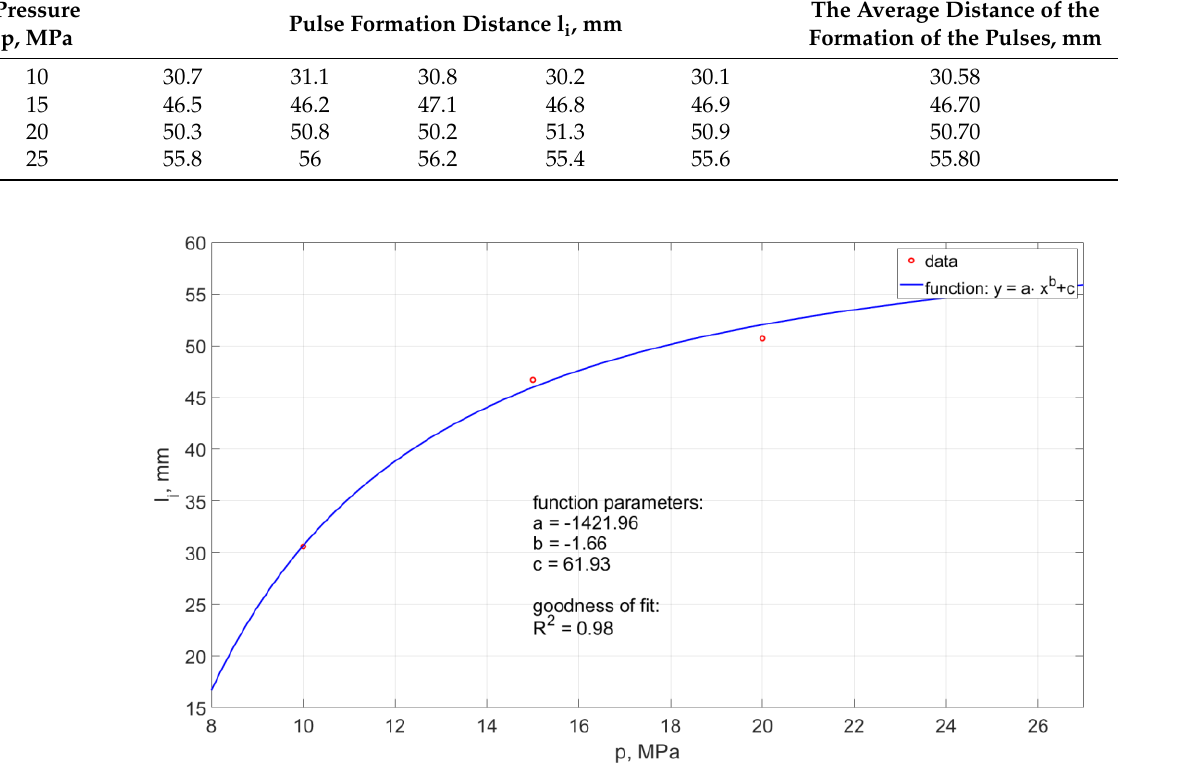
Figure 17. Influence of water pressure on the distance between the formation of hydrodynamic impulses and the outlet from a self-excited pulse head operating in the water environment. The relationship takes the